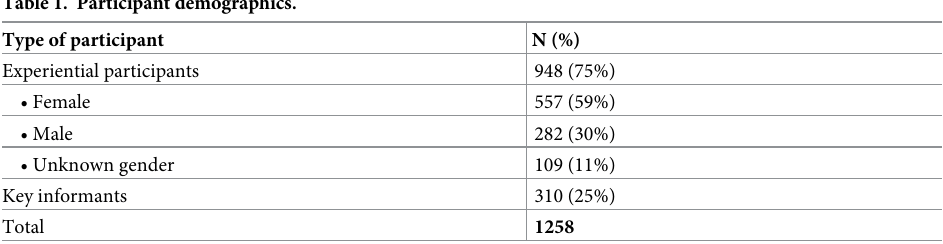
Table 1. Participant